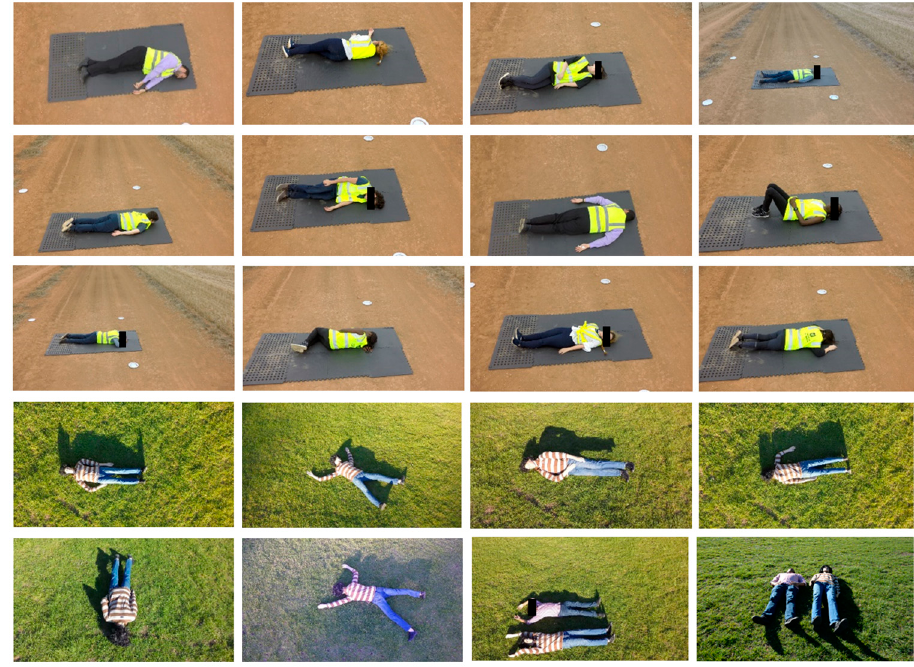
Figure 2. Data acquisition from human subjects and a mannequin at different poses.